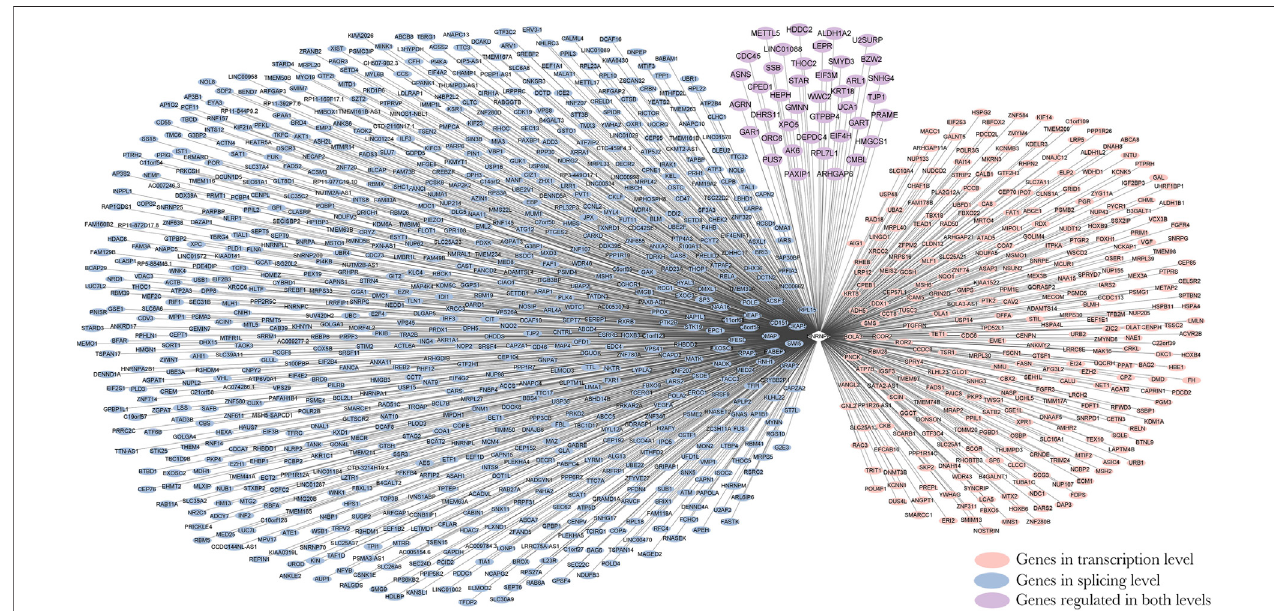
FIGURE 3 | Two-layer regulatory network of Heterogeneous nuclear ribonucleoprotein K (HNRNPK). Pink indicates the target genes of the transcriptional regulatory network of HNRNPK, blue indicates the target genes of splicing regulatory network of HNRNPK, and purple indicates the co-regulated targets of HNRNPK. For more detailed information on genes in the network, please refer to Supplementary Table S7 .